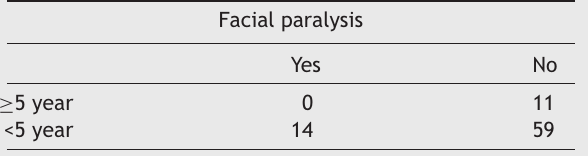
Case-control table --- duration of the disease (5 years).